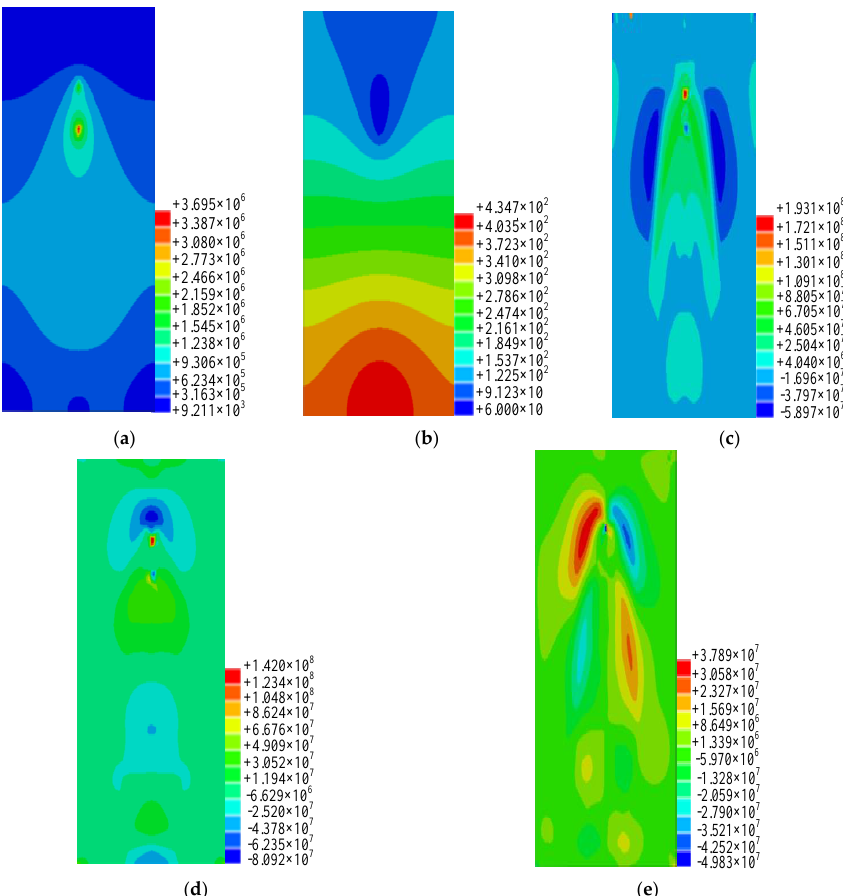
Figure 15. Geometry and boundary conditions of the welding cooling process with an inclined isothermal crack.